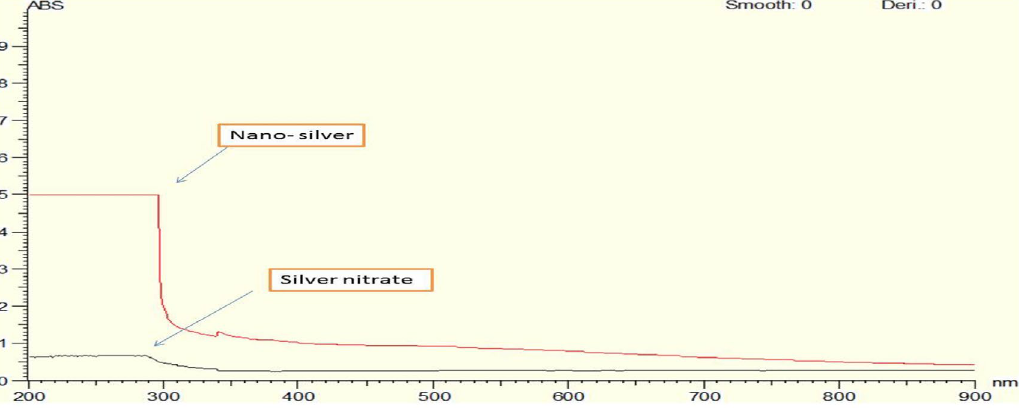
Fig. 11. UV Vis absorption spectra for both chemically and biologically synthesized silver